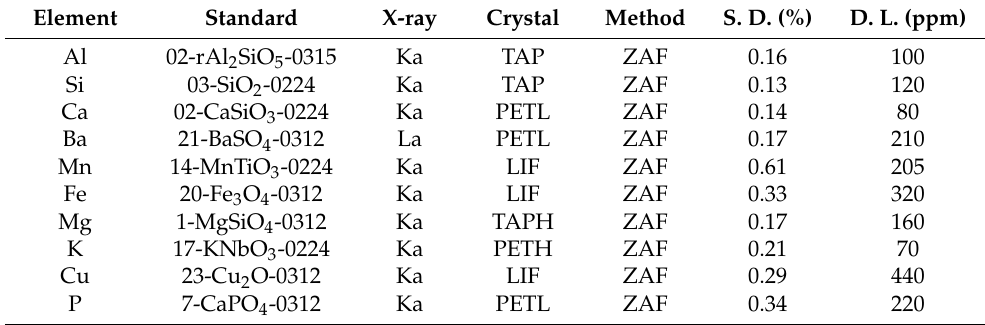
Table 2. The methodology for studying the composition of manganese minerals by EPMA.